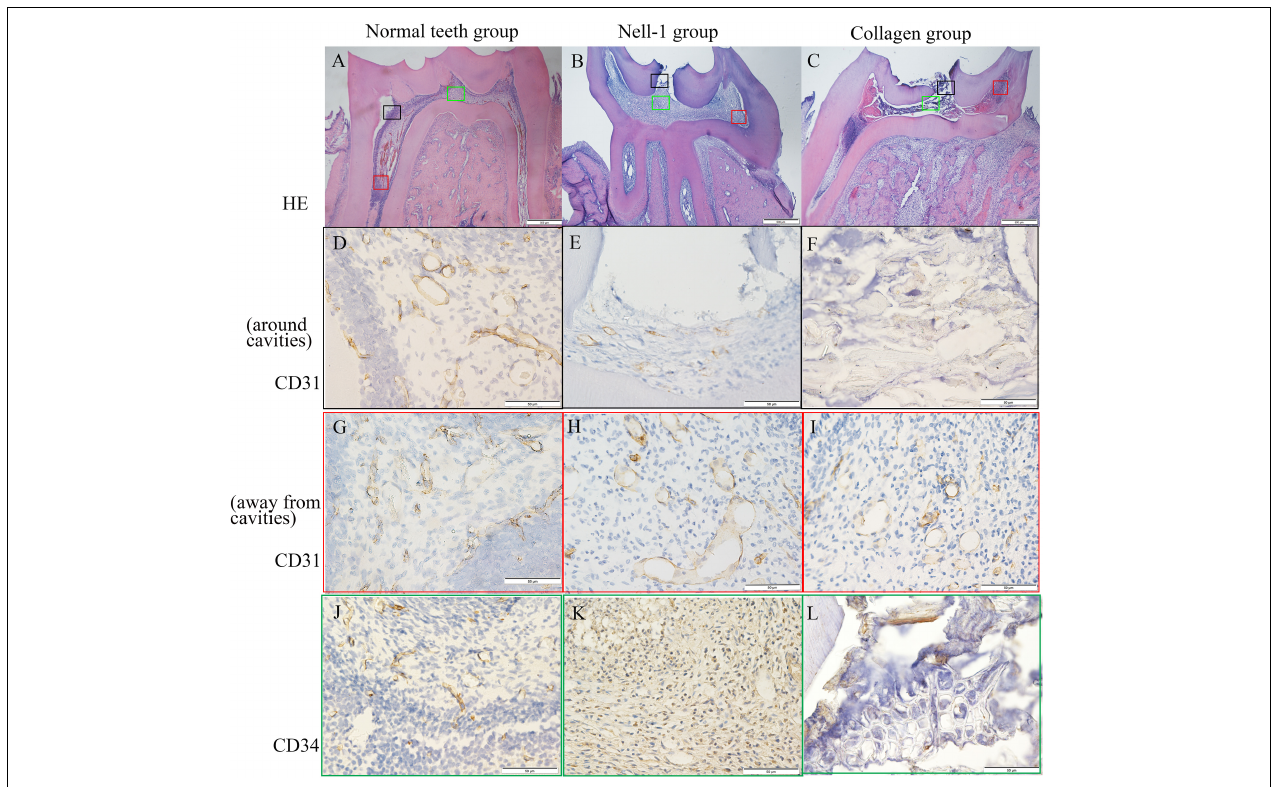
FIGURE 6 | Histology and immunohistochemistry staining. (A) Normal teeth group. (B) Nell-1 group. (C) Collagen group. HE staining showed the cavities, inflamed tissue, and normal structure of rat pulp tissues. The staining of CD31 (D–I) and CD34 (J–L) revealed the blood vessels in pulp tissues. Nell-1 induction group had higher number of blood vessels around cavities than the collagen group, and both of them had fewer blood vessels than negative control group (D–F,J–L) . There was no significant difference in the area away from the cavities between three groups (G–I) . d, dentin; p, dental pulp; bd, blood